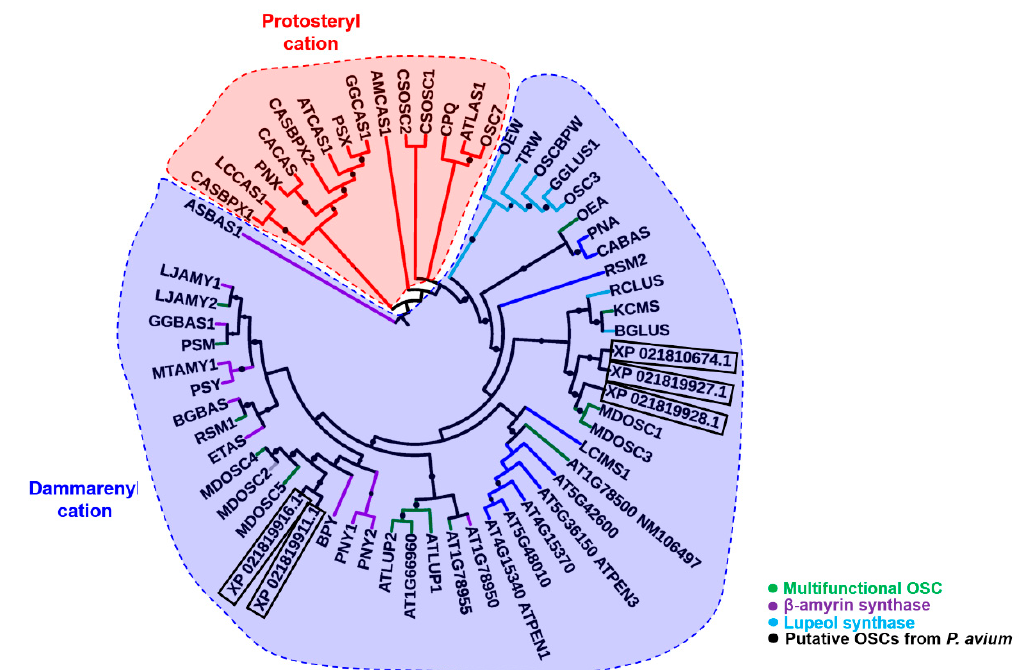
Figure 1. Maximum likelihood phylogenetic tree (number of bootstrap alignments in ultrafast mode: 1000) of different OSC protein sequences (conserved regions only) from the plant species used by Brendolise and colleagues [10] and from sweet cherry (boxed). The branch with MdOSC2 is in gray, as it may represent a non-functional pseudogene. The FASTA protein sequences used to build the tree are provided in Supplementary Information. Boostrap values ranging from 0.8 to 1 are displayed as black circles; the bigger the circle, the higher the bootstrap value.